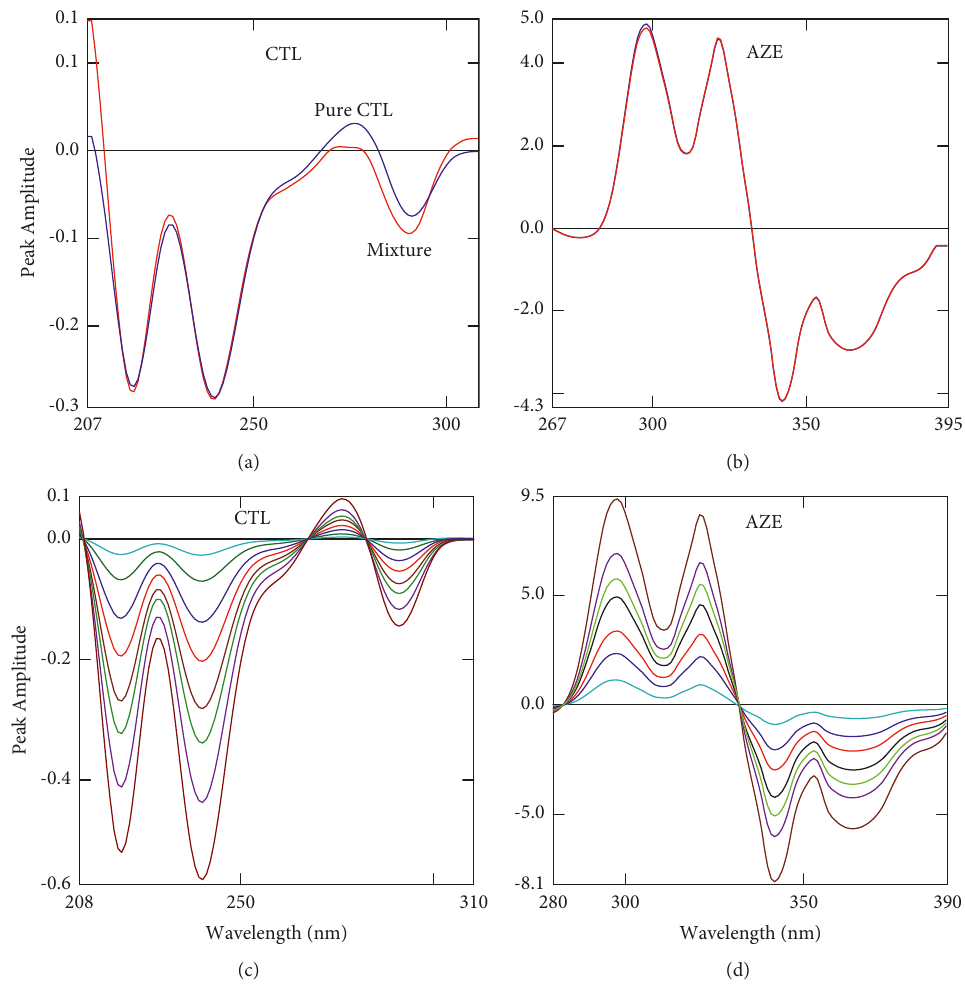
Figure 4: (a) Ratio first derivate spectra of pure CTL (blue) and mixture (red), (b) Ratio first derivate spectra of pure AZE (blue) and mixture (red). (c) Ratio first derivative spectra of CTL (1–15 μ g/mL). (d) Ratio first derivative spectra of AZE (1–15 μ